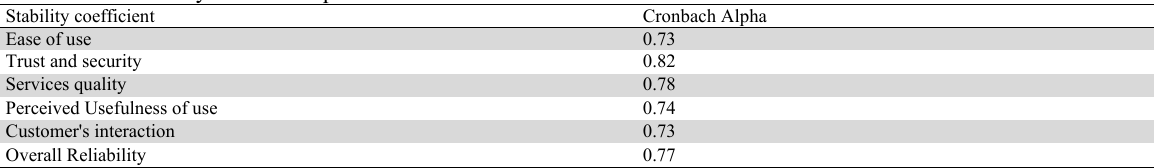
Instruments reliability cornbach alpha